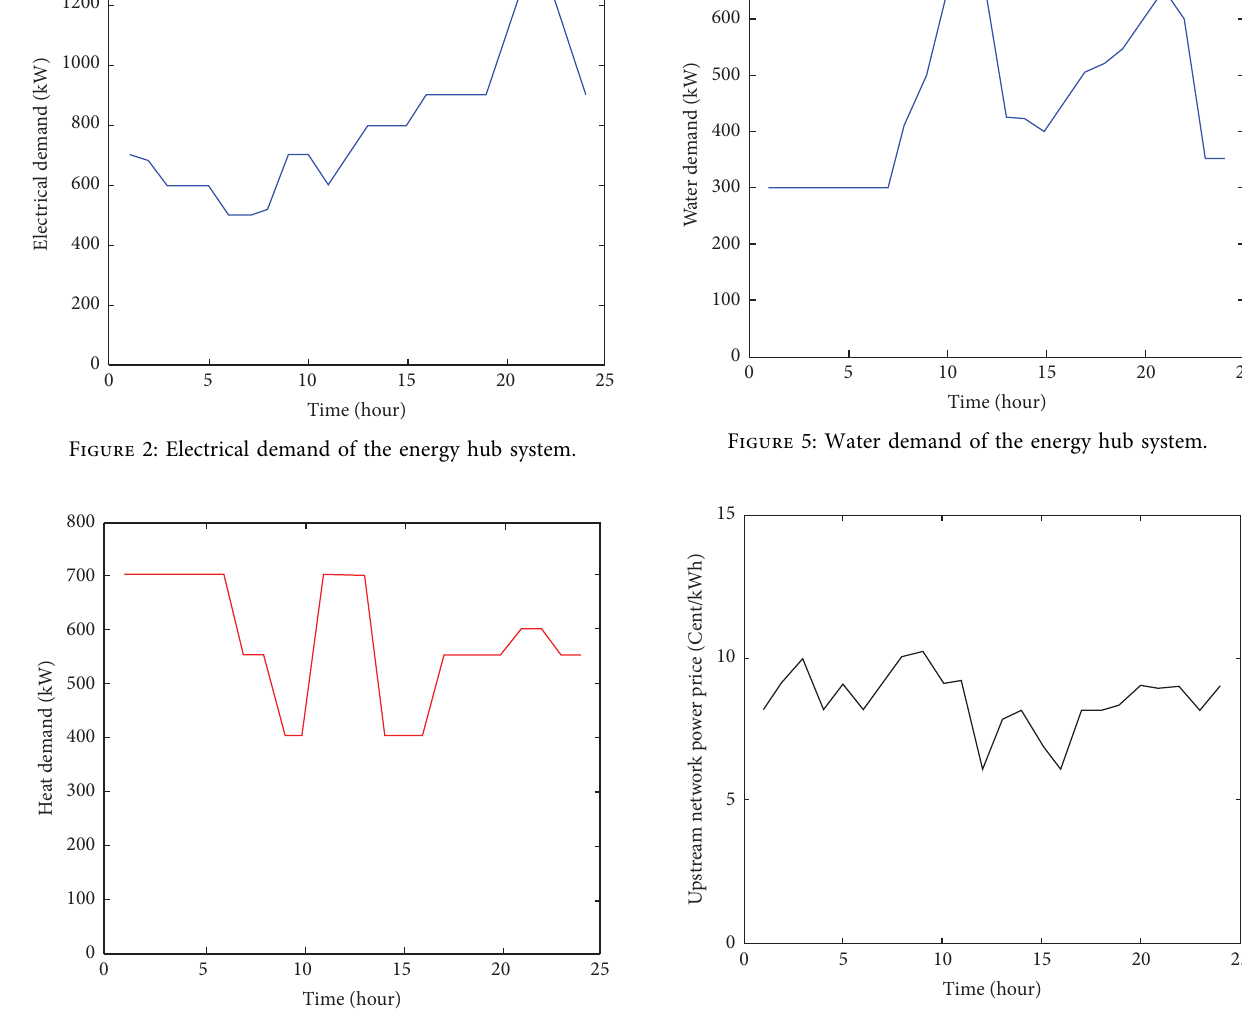
Figure 6: Price of the upstream network.